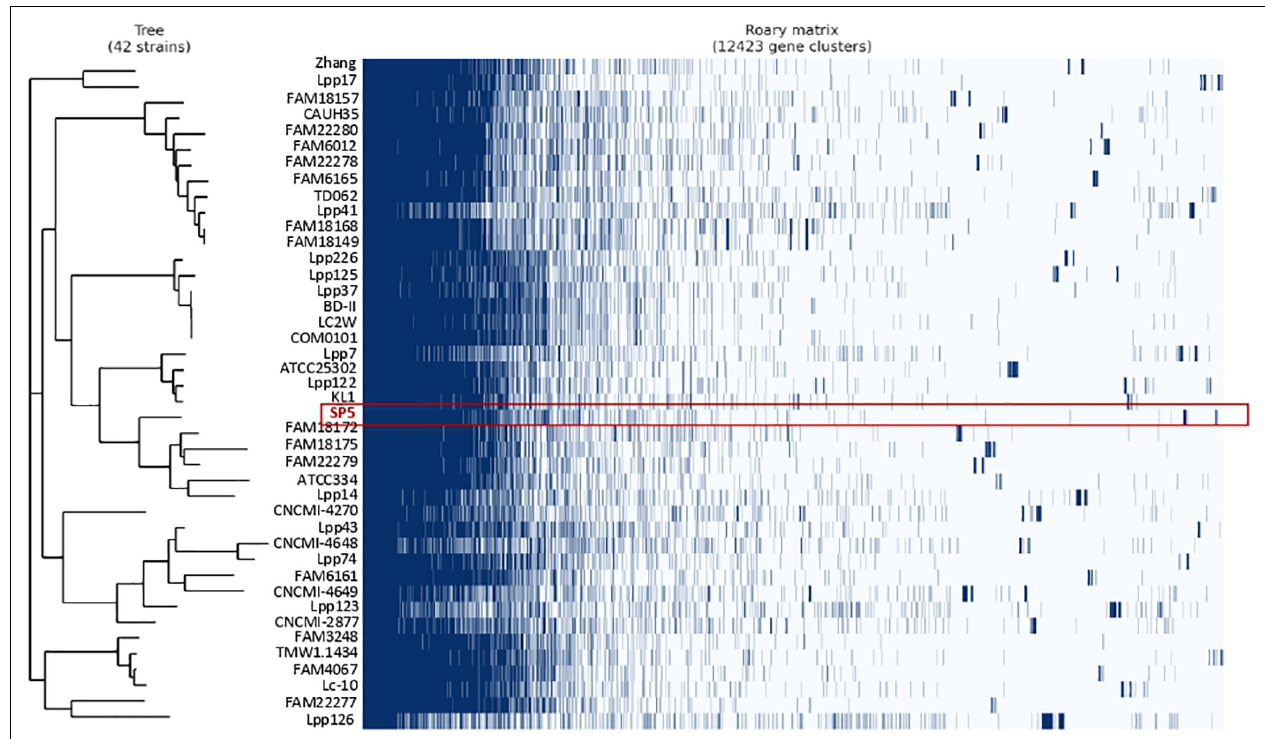
FIGURE 4 | Pangenome analysis of Lc. paracasei strains isolated from fermented milk products, performed using Roary (version 3.13.0). The absence (white) or presence (dark blue) of core and accessory genes are depicted in the matrix. Highlighted in red are clusters assigned to Lc. paracasei